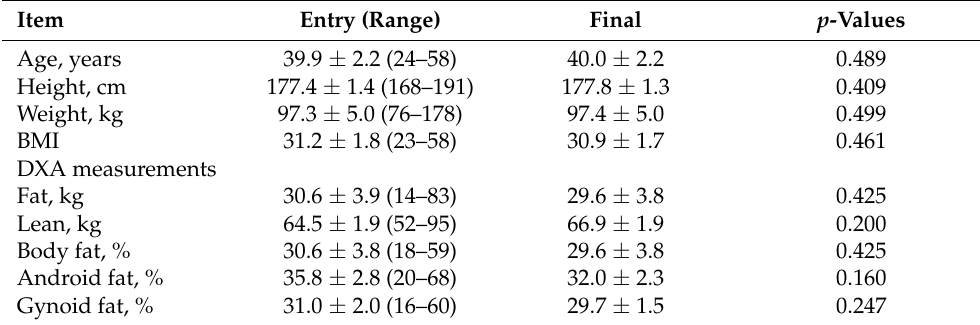
Table 2. Physiological demographics and DXA-measured body composition for men at baseline and after consumption of ground beef patties (5 patties/week for 5 weeks) initially containing 6 g fat/patty and 27 g fat/patty 1